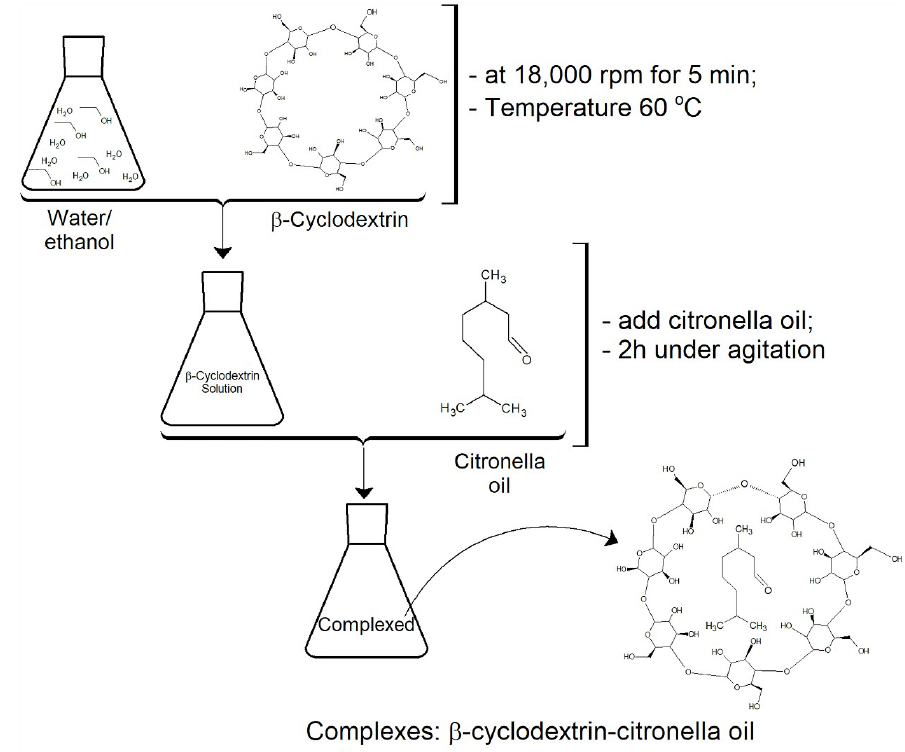
Figure 3. mRNA expression profile of mitochondrial encoded genes in diabetic heart and effect Figure 3. Experimental protocol followed for the formation of inclusion complexes CD–citronella of resveratrol administration . Data shown as mean DIA group.